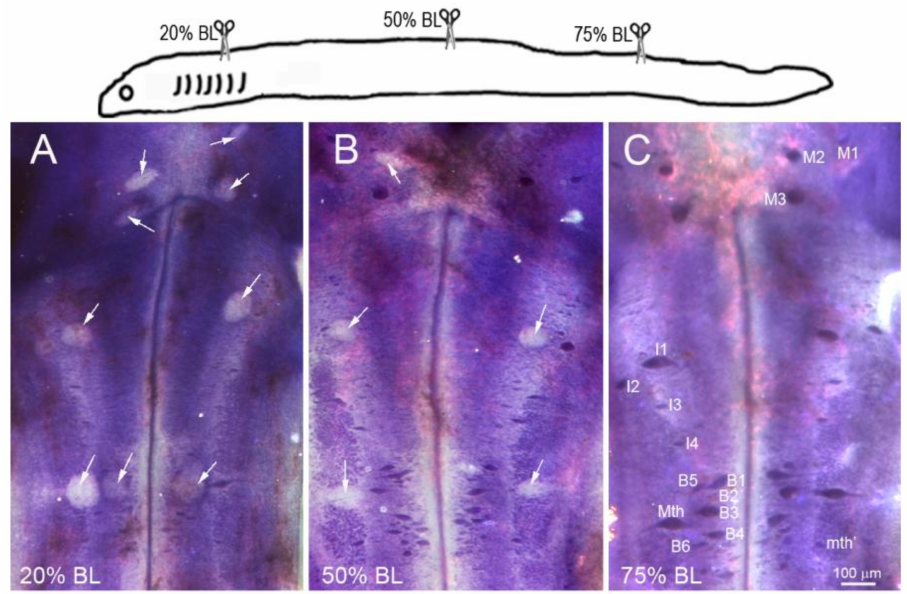
Figure 5. The identified RS neurons projected at least to 75% body length (BL). RS neurons were retrogradely labeled by D-AF488 applied to a fresh TX at 20% BL (5th gill, ( A )) or 75% BL ( B ). The brains were removed and fixed 2 weeks post-TX. All the identified RS neurons except I6 (faintly seen in ( A ), magenta label) project to at least 75%